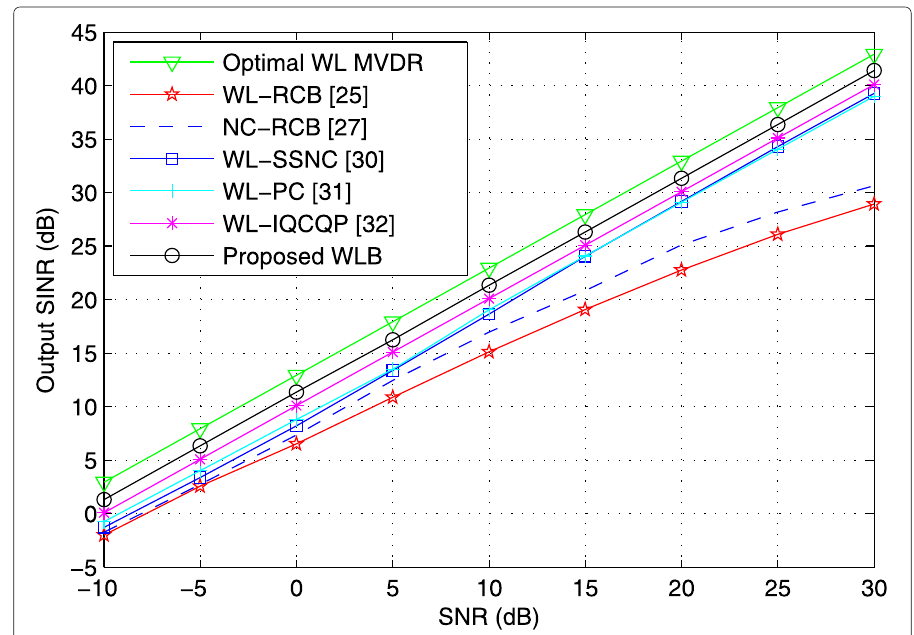
Fig. 10 Example 5. Output SINR of all WLBs versus the input SNR